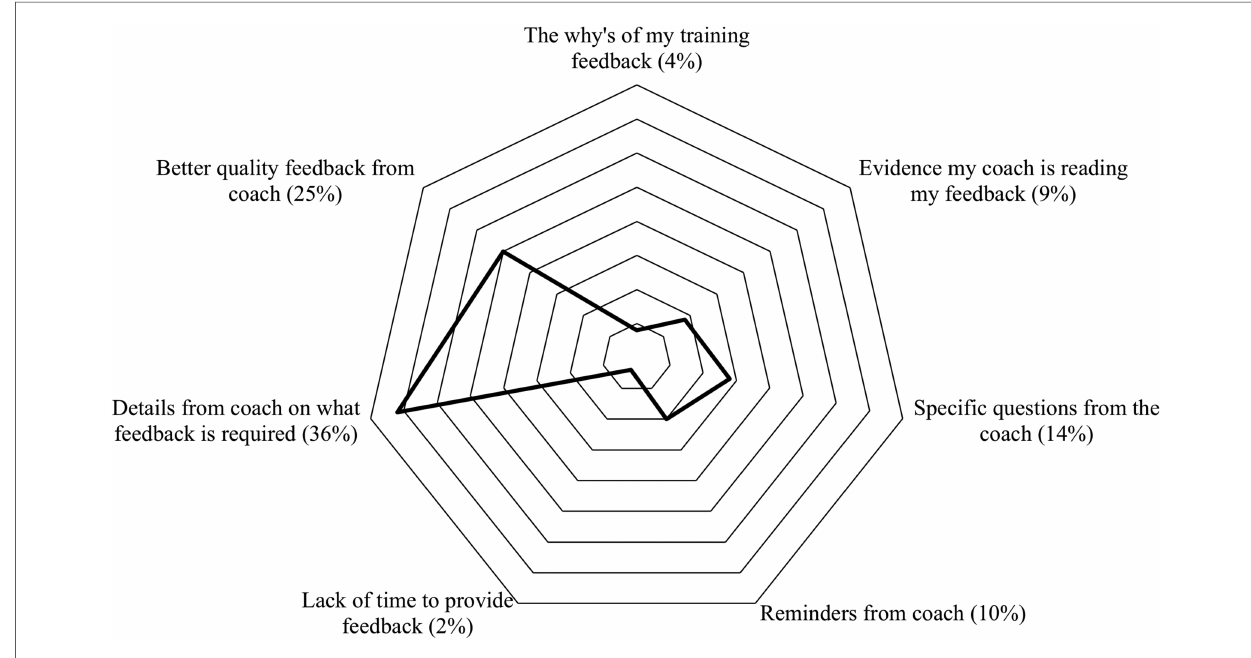
FIGURE 1 Reasons how coaches could help athletes provide better